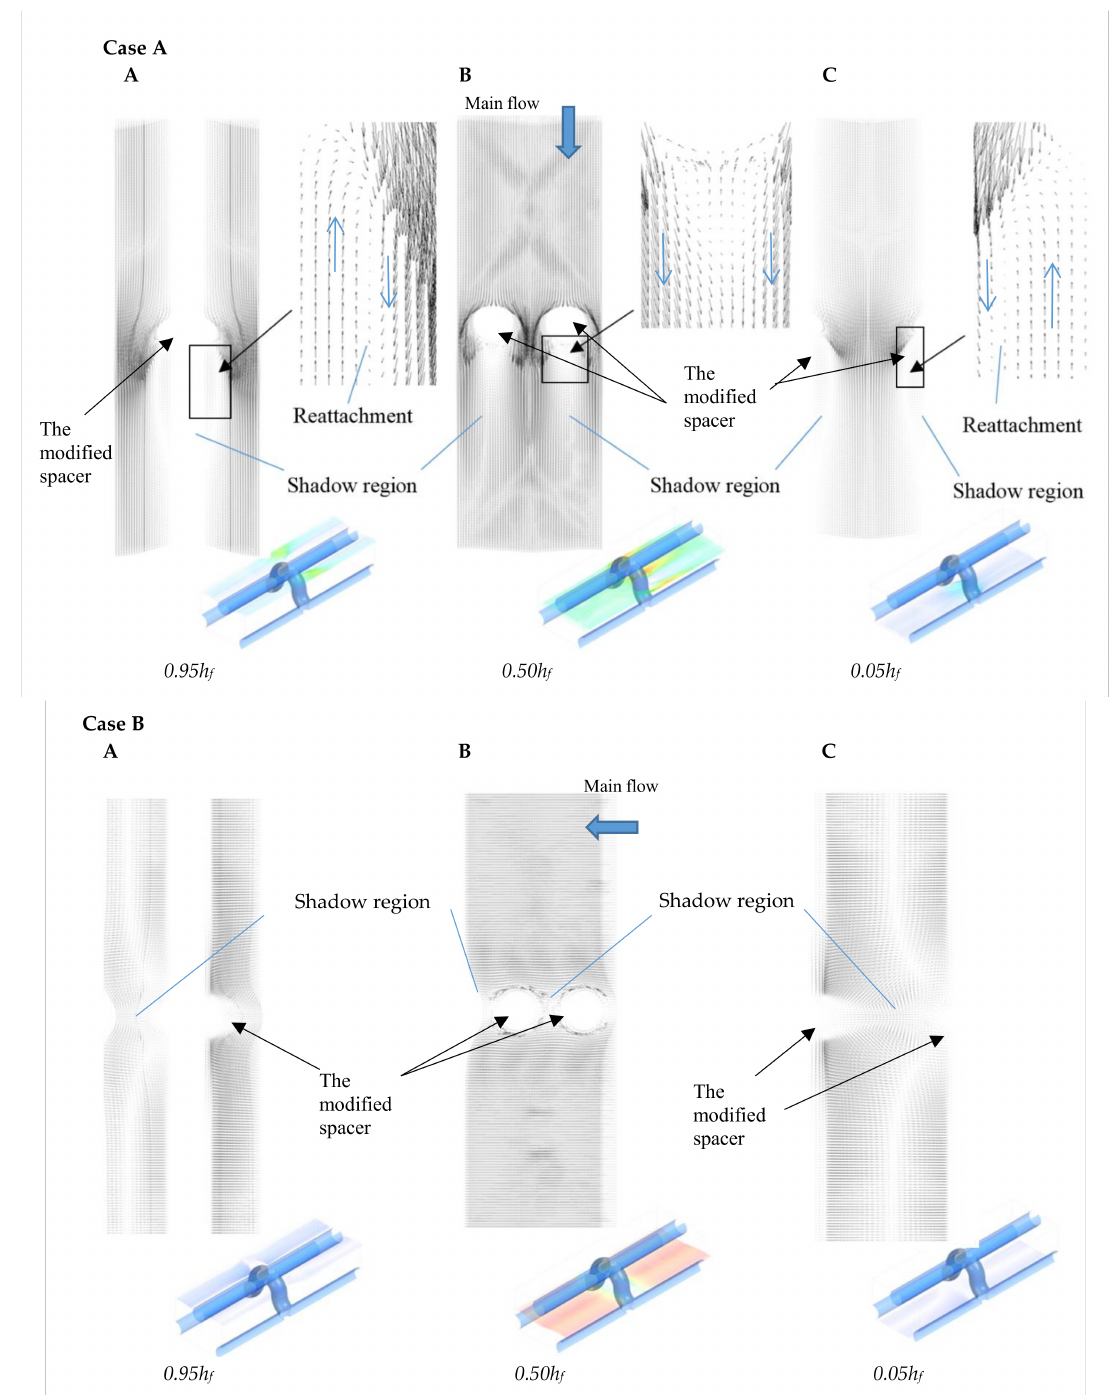
Figure 7. Velocity vectors in case A and case B ( L / D = 12, U sup = 0.06 m s − 1 ; in ( case A ), the main flow was from up to down, and in ( case B ), the main flow was from right to left for ( A ) 0.95 h f , ( B ) 0.50 h f , and ( C ) 0.05 h f